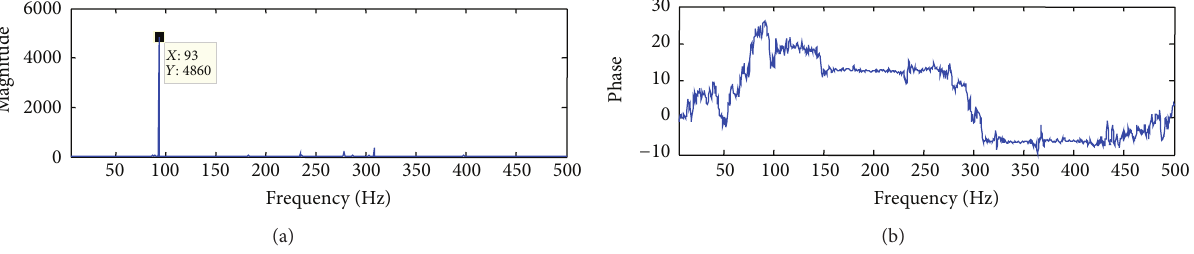
Figure 8: Fictitious frequency response function in the case of a fault on the outer race of the ball bearing: (a) magnitude spectrum and (b) phase spectrum.